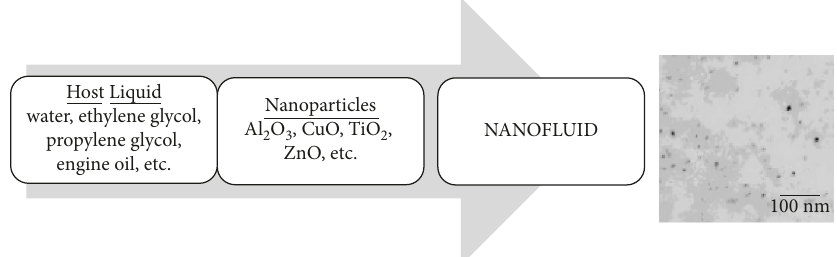
Figure 3: Schematic description of a nanofluid: base fluid in combination with nanoparticles.